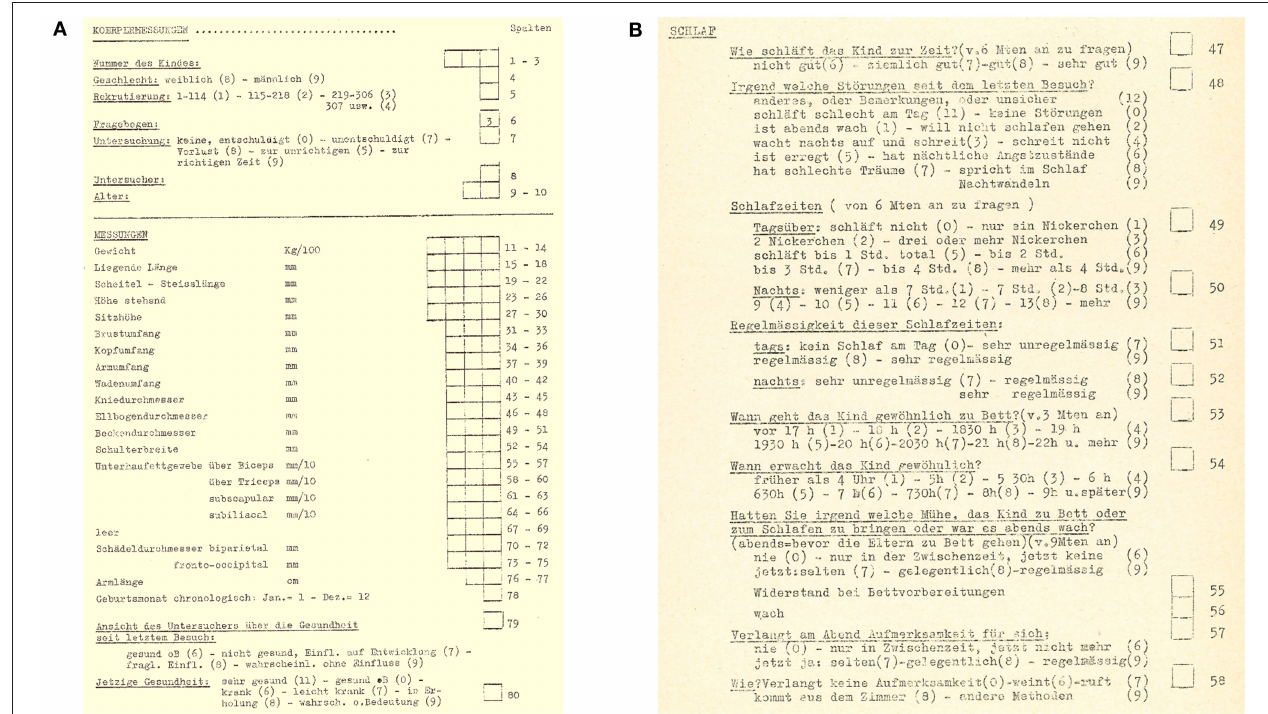
FIGURE 6 | Illustration of standardized record forms used for all three cohorts during ZLS-Childhood. (A) Assessment of anthropometric measures. (B) Assessment of sleep quantity and quality (see Supplementary Material 1 for English